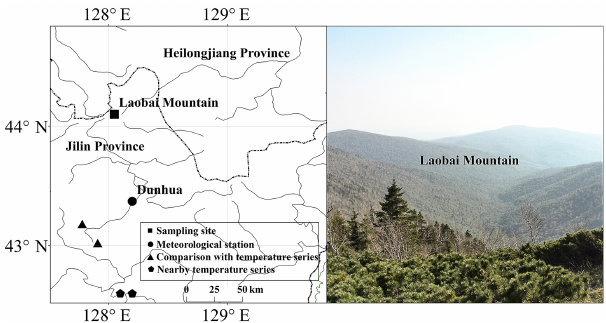
Figure 1. Map of the sampling site, the compared temperature series, nearby temperature series, and the meteorological station in northeast China. The photo shows the sampled site on Laobai Mountain and the remarkable vertical vegetation distribution along altitude